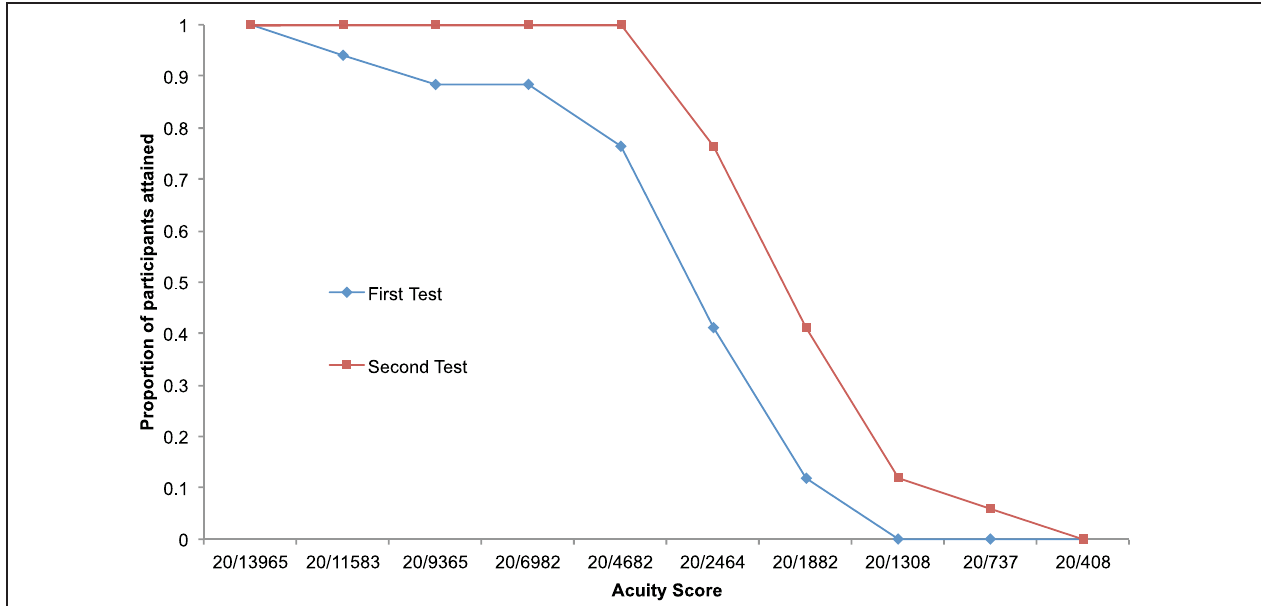
FIGURE 4 | Difference in participants’ performance between experiment 1 and experiment 2. Proportion of participants achieving each acuity score (9/12 correct responses) is shown as a function of increasing acuity score.